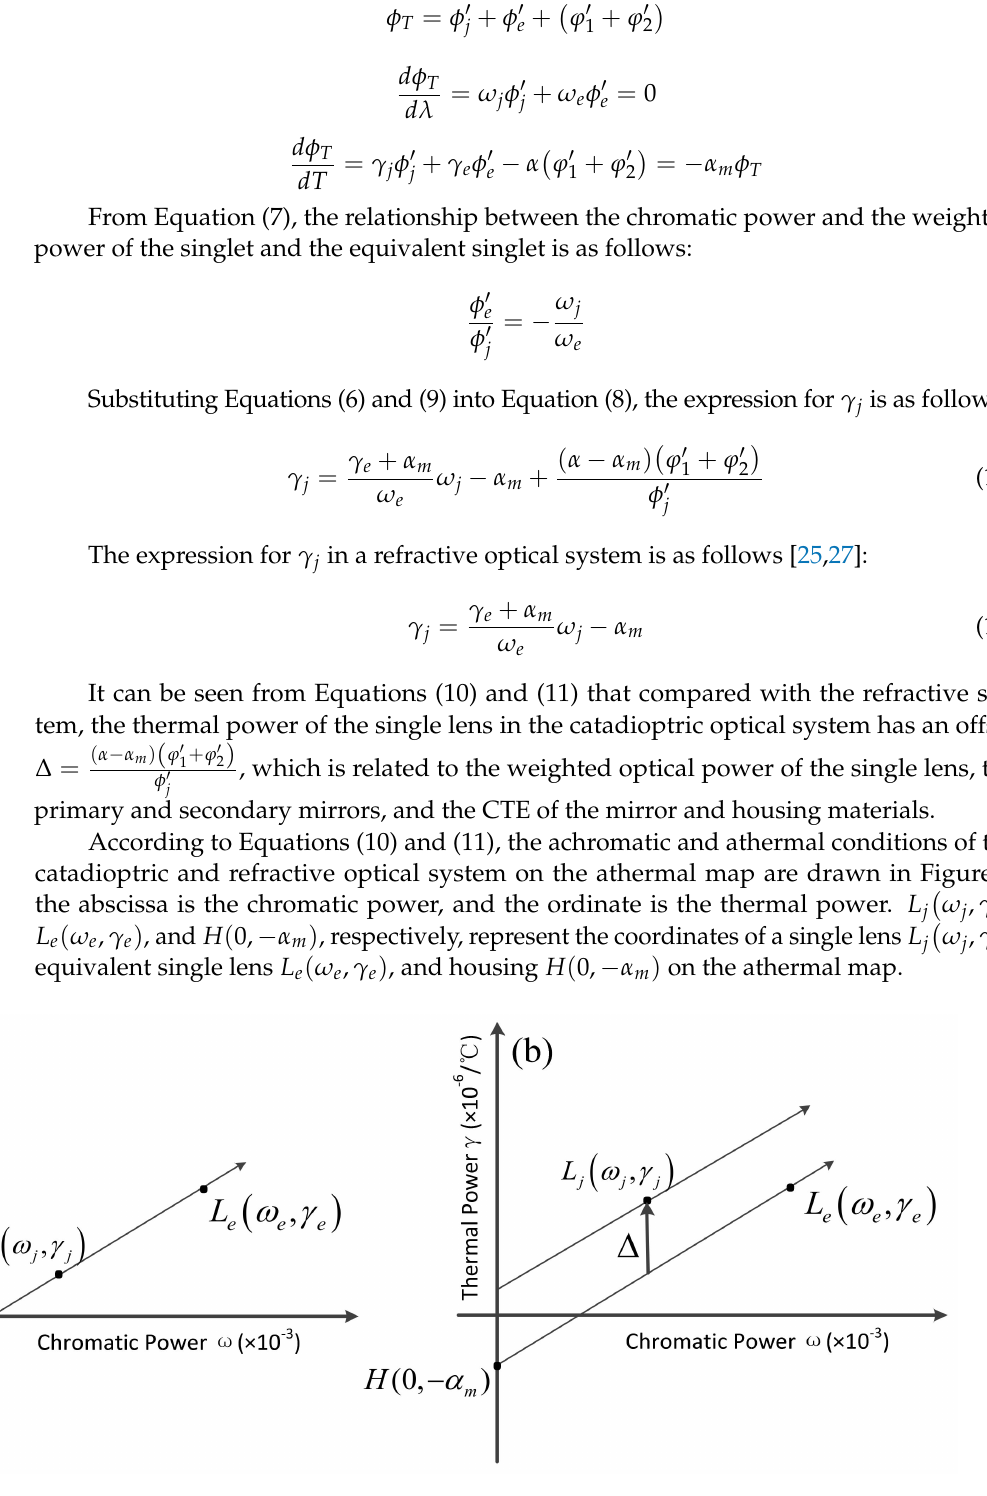
Figure 2. Achromatic and athermal conditions on an athermal map of ( a ) refractive optical system and ( b ) catadioptric optical